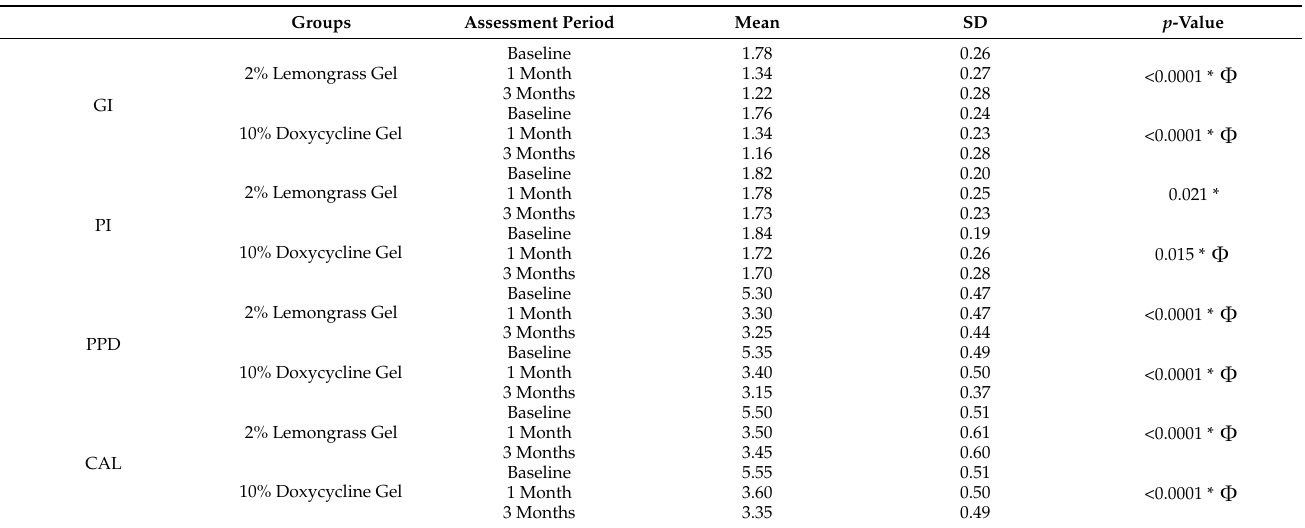
Table 1. Comparison of mean scores of both clinical and microbiological parameters at baseline.